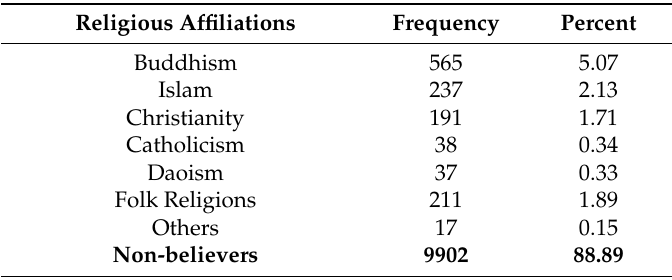
Table 1. The Distribution of Religious Affiliations in CGSS